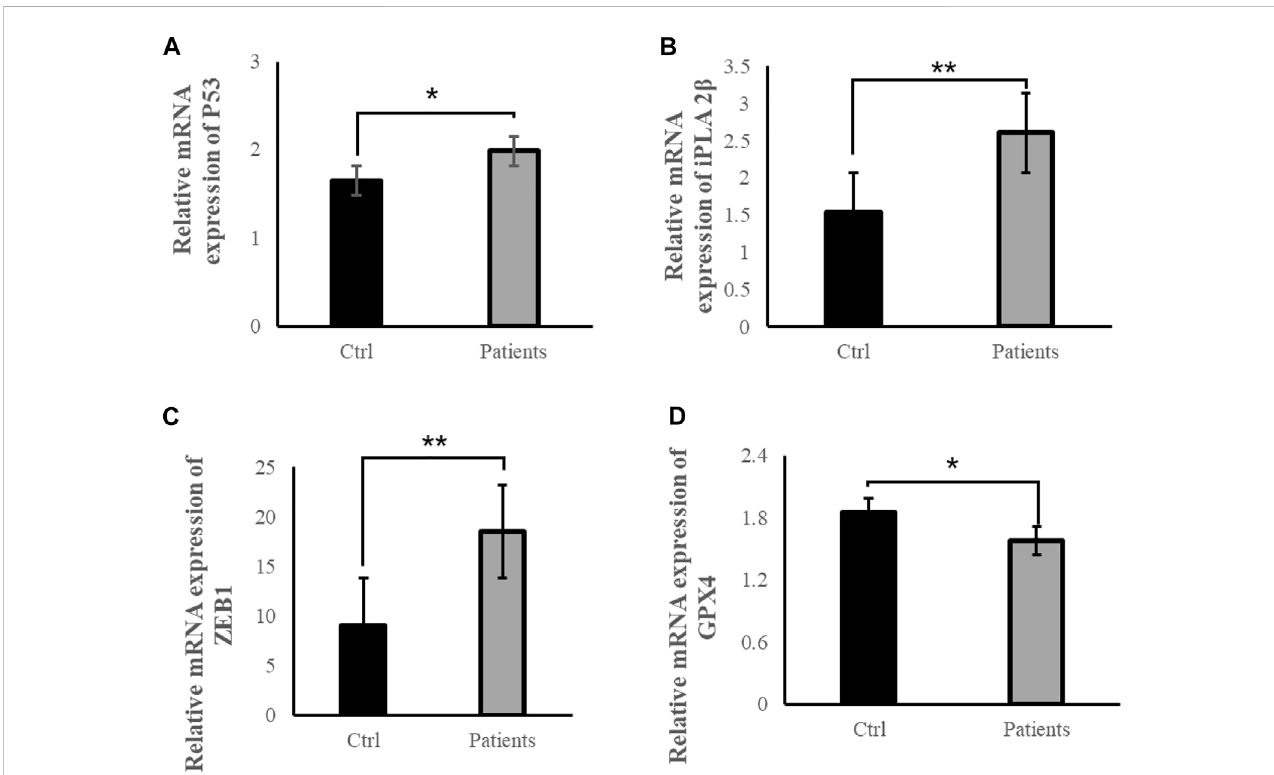
ROS exposureactivated ferroptosis-related signal pathways in human spermatozoa. (A) Relative mRNA expressionof P53 , (B) Relative mRNA expression of iPLA 2 β , (C) Relative mRNA expression of ZEB1 , (D) Relative mRNA expression of GPX4 . All data are displayed as means ± s.e.m. (* p < 0.05, ** p < 0.01; Student ’ s t -test).